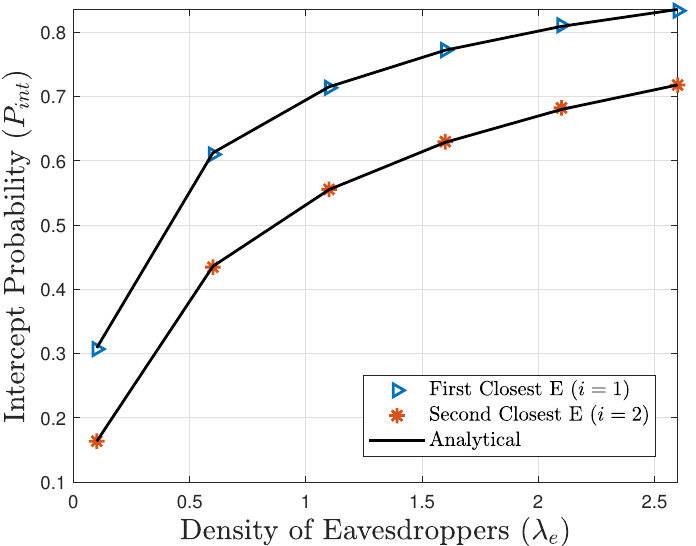
Figure 7. The intercept probability ( P int ) versus the density of E for different values of i . For the main channel, κ = 1, µ = 1, and for the wiretap channel, κ e = 1, µ e = 1. ¯ γ E = 1 dB, ¯ γ B = 5 dB, N = 2, n e = 2, α = 2, K =